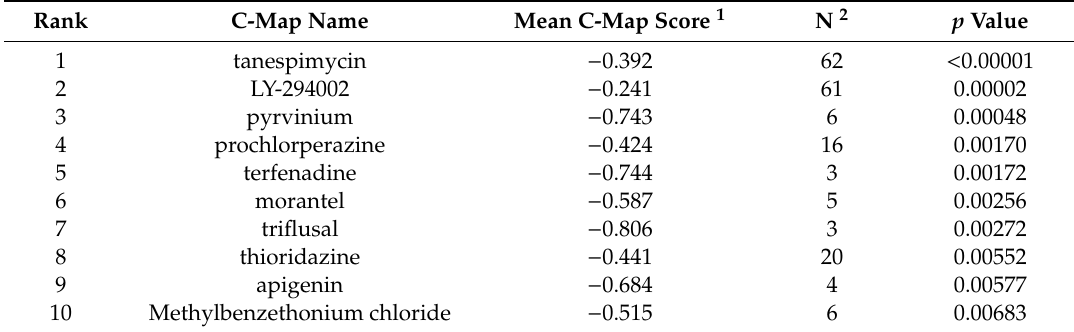
Table 1. Connectivity Map (C-Map) permuted results showing the natural compounds with significant negative correlation to adipogenesis gene